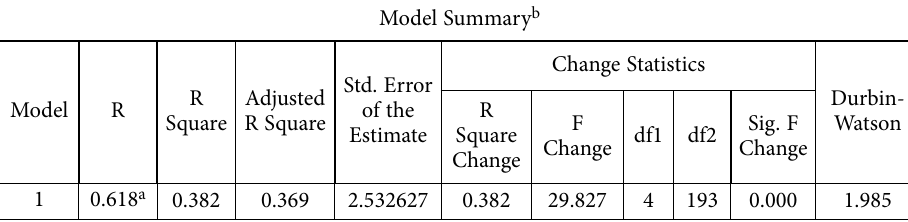
Table 6. Model summary and ANOVA (Asia) (source: own construction by using